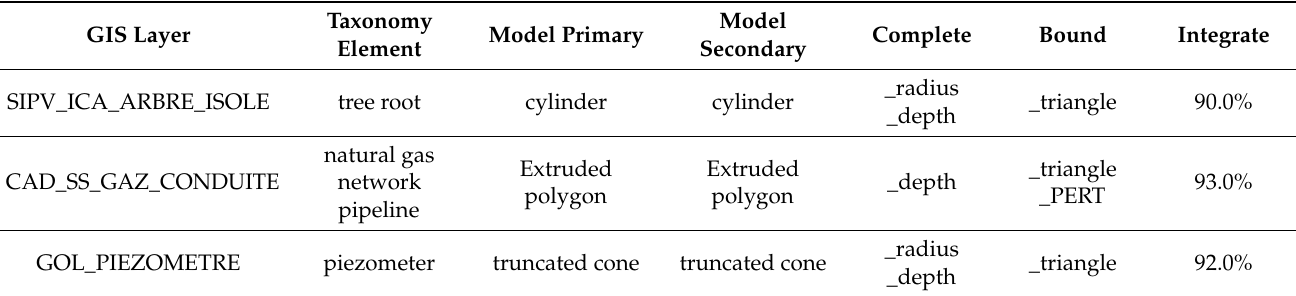
Table 2. Flow from the GIS layer towards RDF triple store